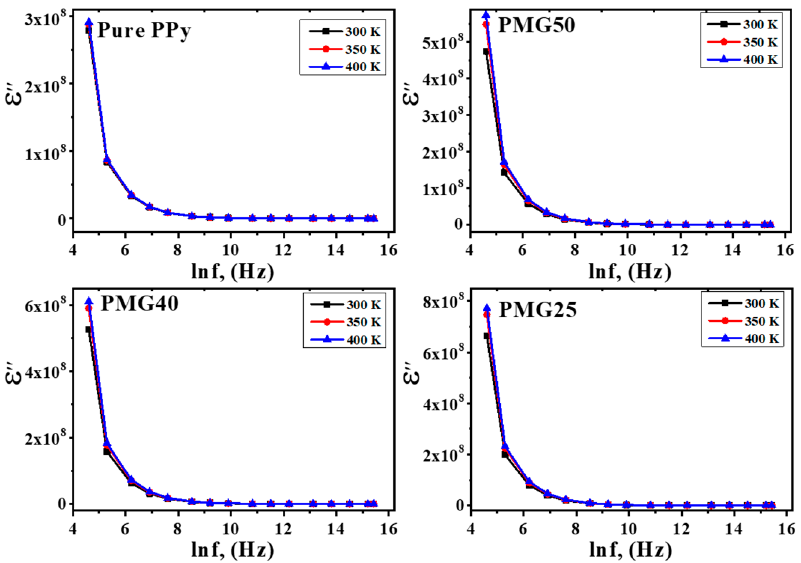
Figure 7. The dielectric loss ( ε ″ ) versus frequency at different temperatures for pure PPy and PMG composites with different ratios.